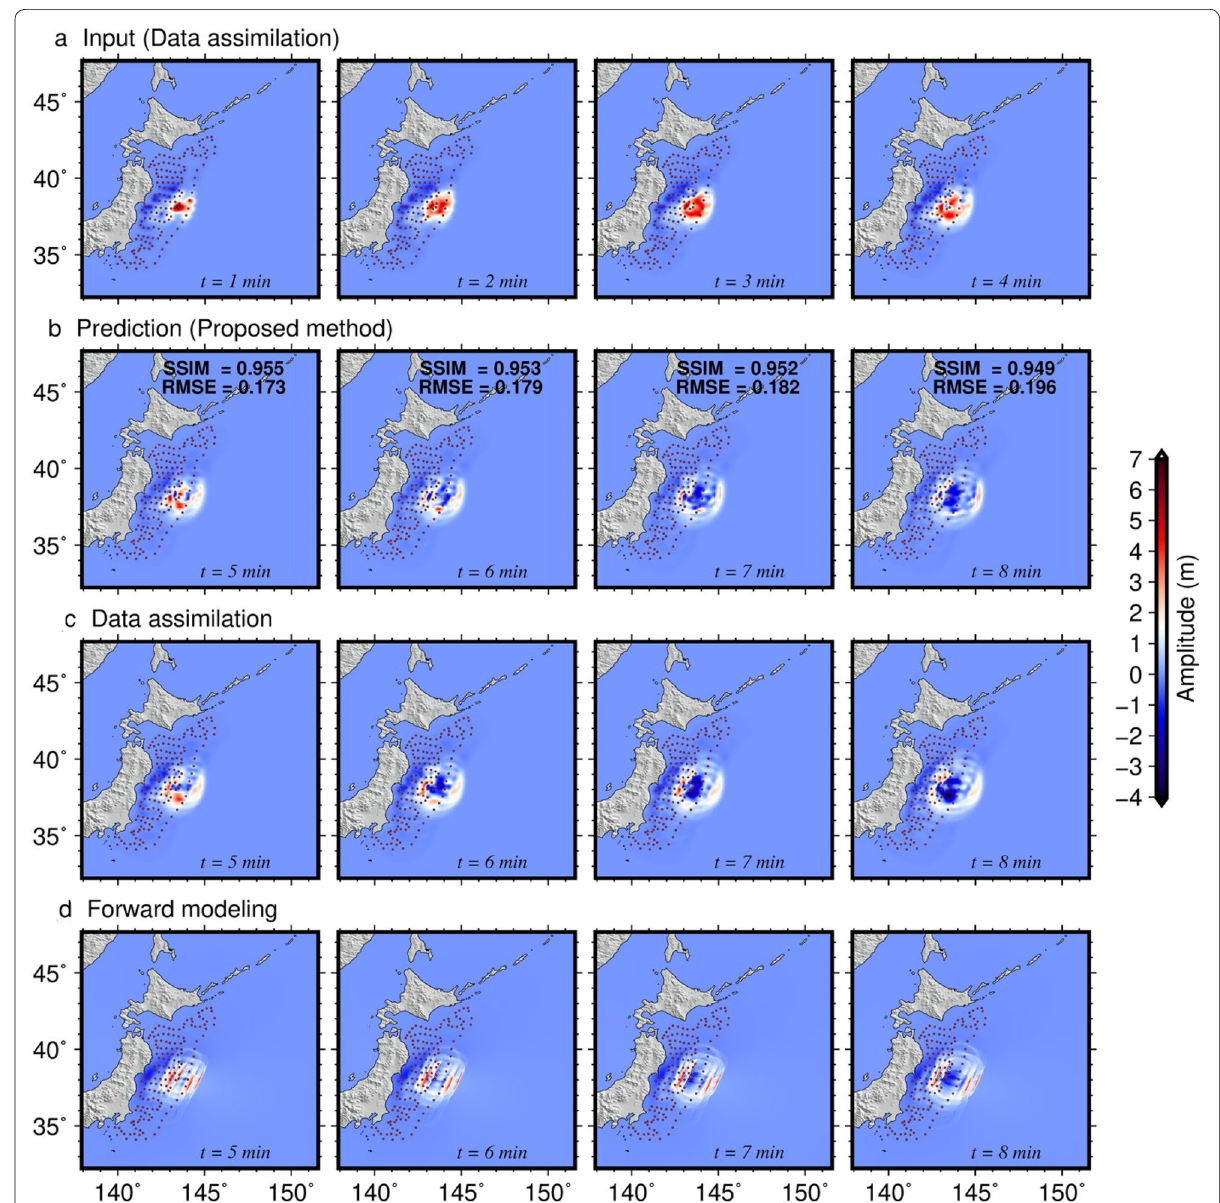
Fig. 8 Comparisons of the wavefields for the model input and the estimated wavefields from the proposed method, DA and forward modeling for the 2011 Tohoku tsunami. a Input to the model; b forecasted tsunami wavefields; c assimilated tsunami wavefields; d results of forward